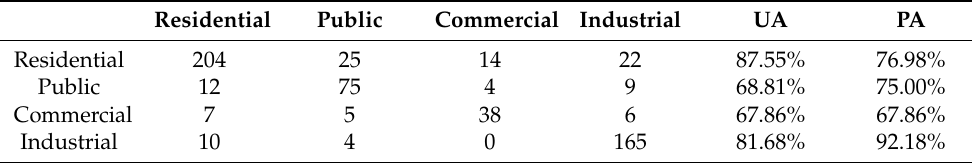
Table 3. Grid confusion matrix for Level I (2800 training & 600 testing